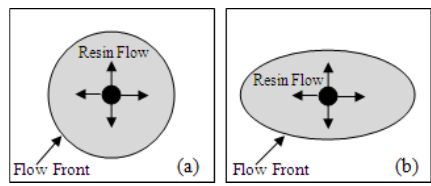
Figure 2: Shapes of flow front in 2D Radial Flow experiments (a) Isotropic (b)